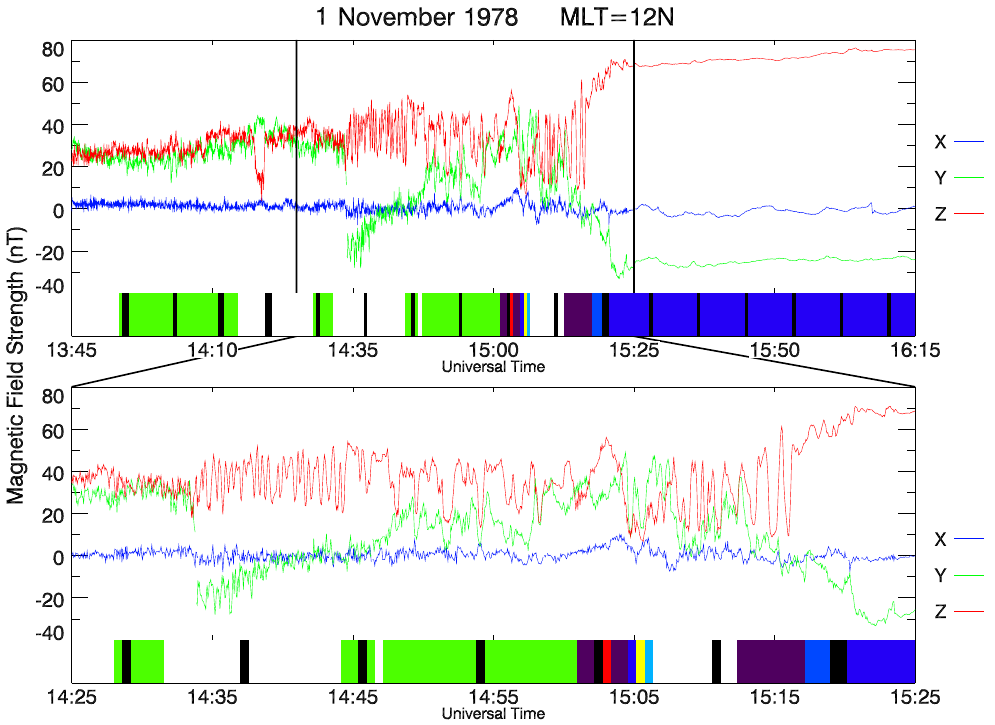
Fig. 10. A plot in the format of Fig. 4 for 1 November 1978 (Day305) from 13:45UT to 16:15UT.